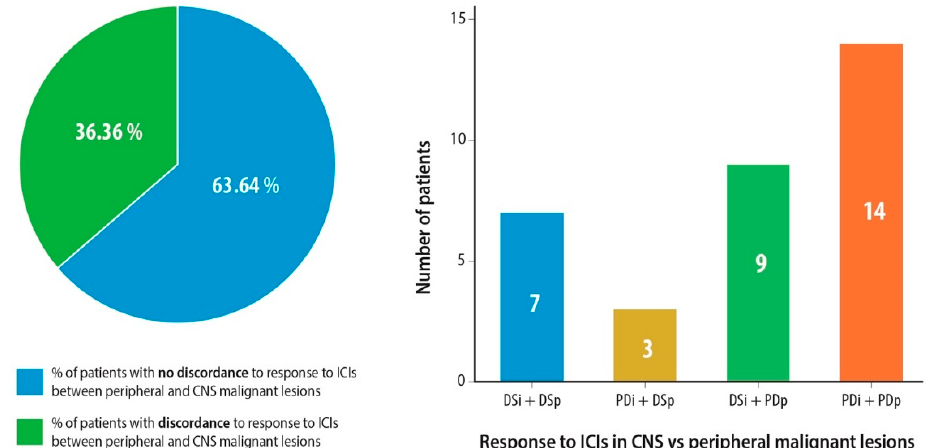
Figure 3. Discordance in disease stabilization (partial response or stable disease) after ICI administration between CNS and peripheral lesions. Abbreviations: ICIs = Immune Checkpoint Inhibitors, DSp = Peripheral Disease Stabilization, PDi = Intracranial Disease Progression, DSi = Intracranial Disease Stabilization, PDp = Peripheral Progressive Disease.